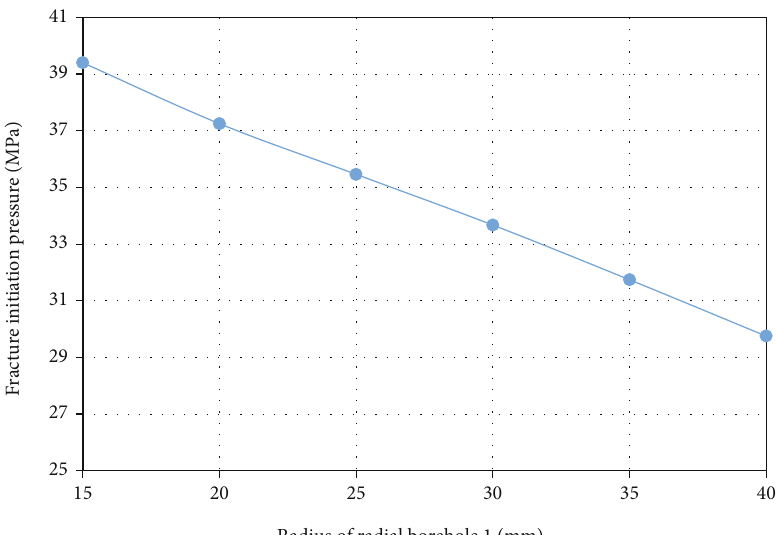
Figure 10: FIP with di ff erent radius of radial borehole 1.